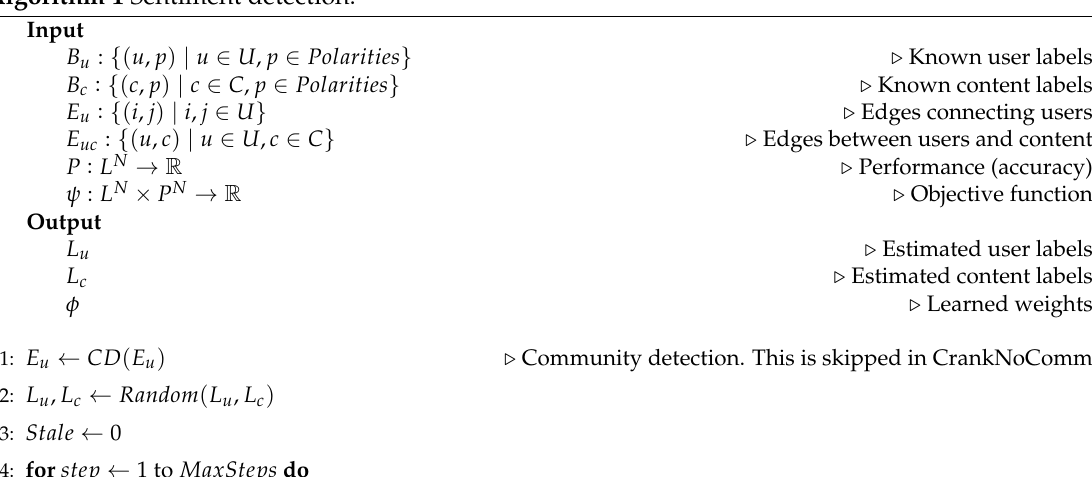
Algorithm 1 Sentiment